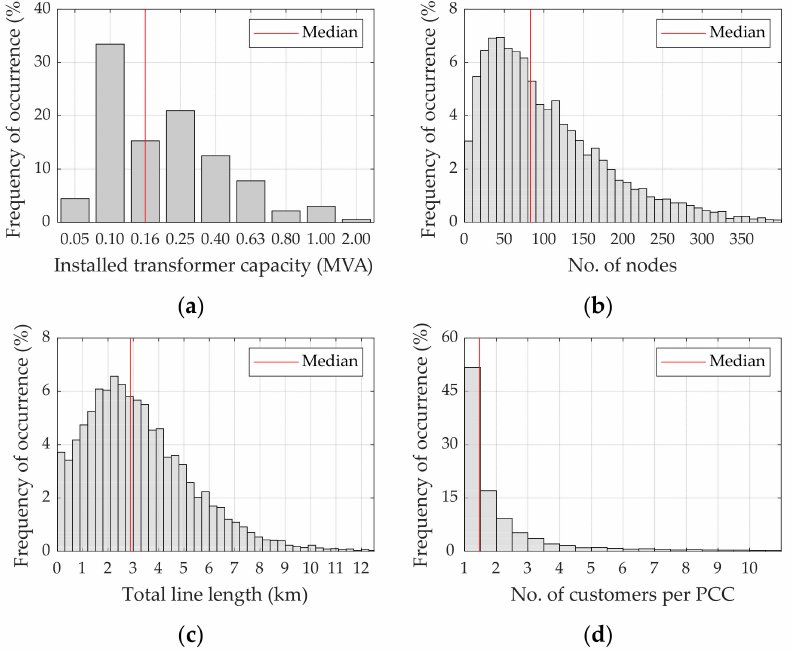
Figure 7. Frequency of occurrence of ( a ) the installed transformer capacity, ( b ) the number of nodes, ( c ) the total line length, and ( d ) the number of customers per point of common coupling (PCC) in the analyzed LV